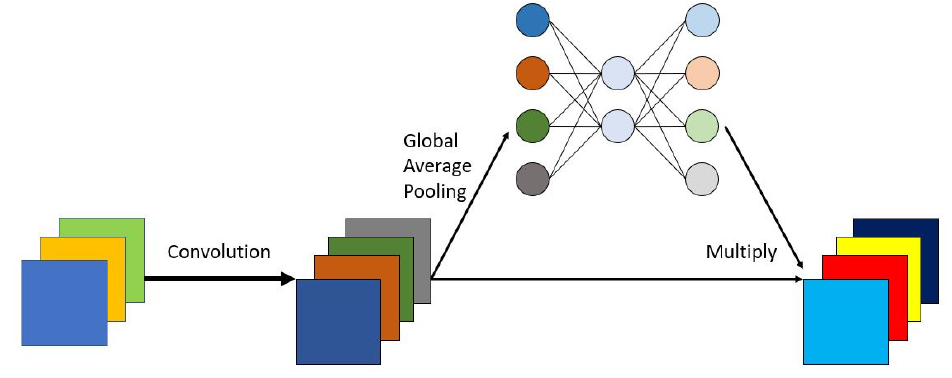
Figure 4. Explanatory drawing of the normal convolution operation.